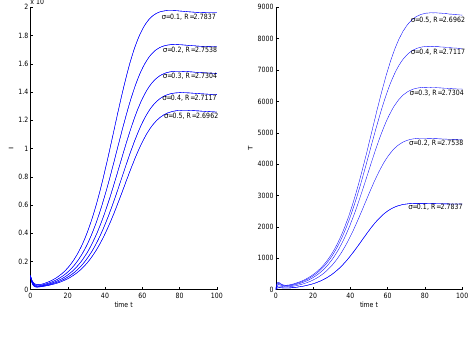
Figure 2. Profile of the T and I classes for the following parameter values µ = 0 . 06 , p 1 = 0 . 5 , ν 1 = 0 . 6 , ν 2 = 0 . 7 , ǫ = 0 . 06 , b = 0 . 03 , π = 10000 , d = 0 . 04 , β 1 = 0 . 4 , β 2 = 0 . 04 , β 3 = 0 . 3 , µ 0 = 0 . 001 , τ = 13 years, c = 4 , ρ = 0 and q = 0 . 01 .